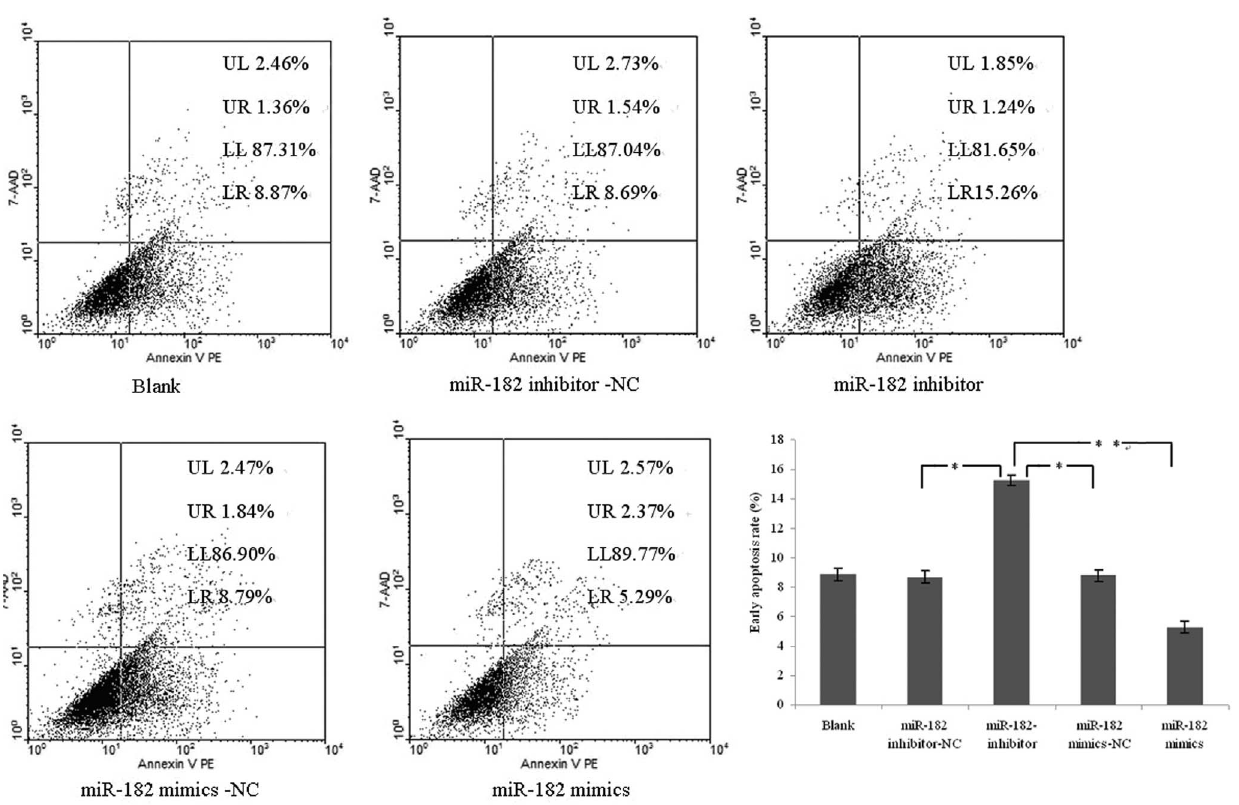
Figure 7. Early apoptosis detection of PC-3 cells transfected with miR-182 mimics or inhibitors. Blank presents blank control. The results show that the early apoptosis rate is lowest in miR-182 mimics group and highest in miR-182 inhibitor group (* P , 0.05, ** P , 0.01). Representative images were shown and early apoptosis cells were indicated at Q4 (LR) area.